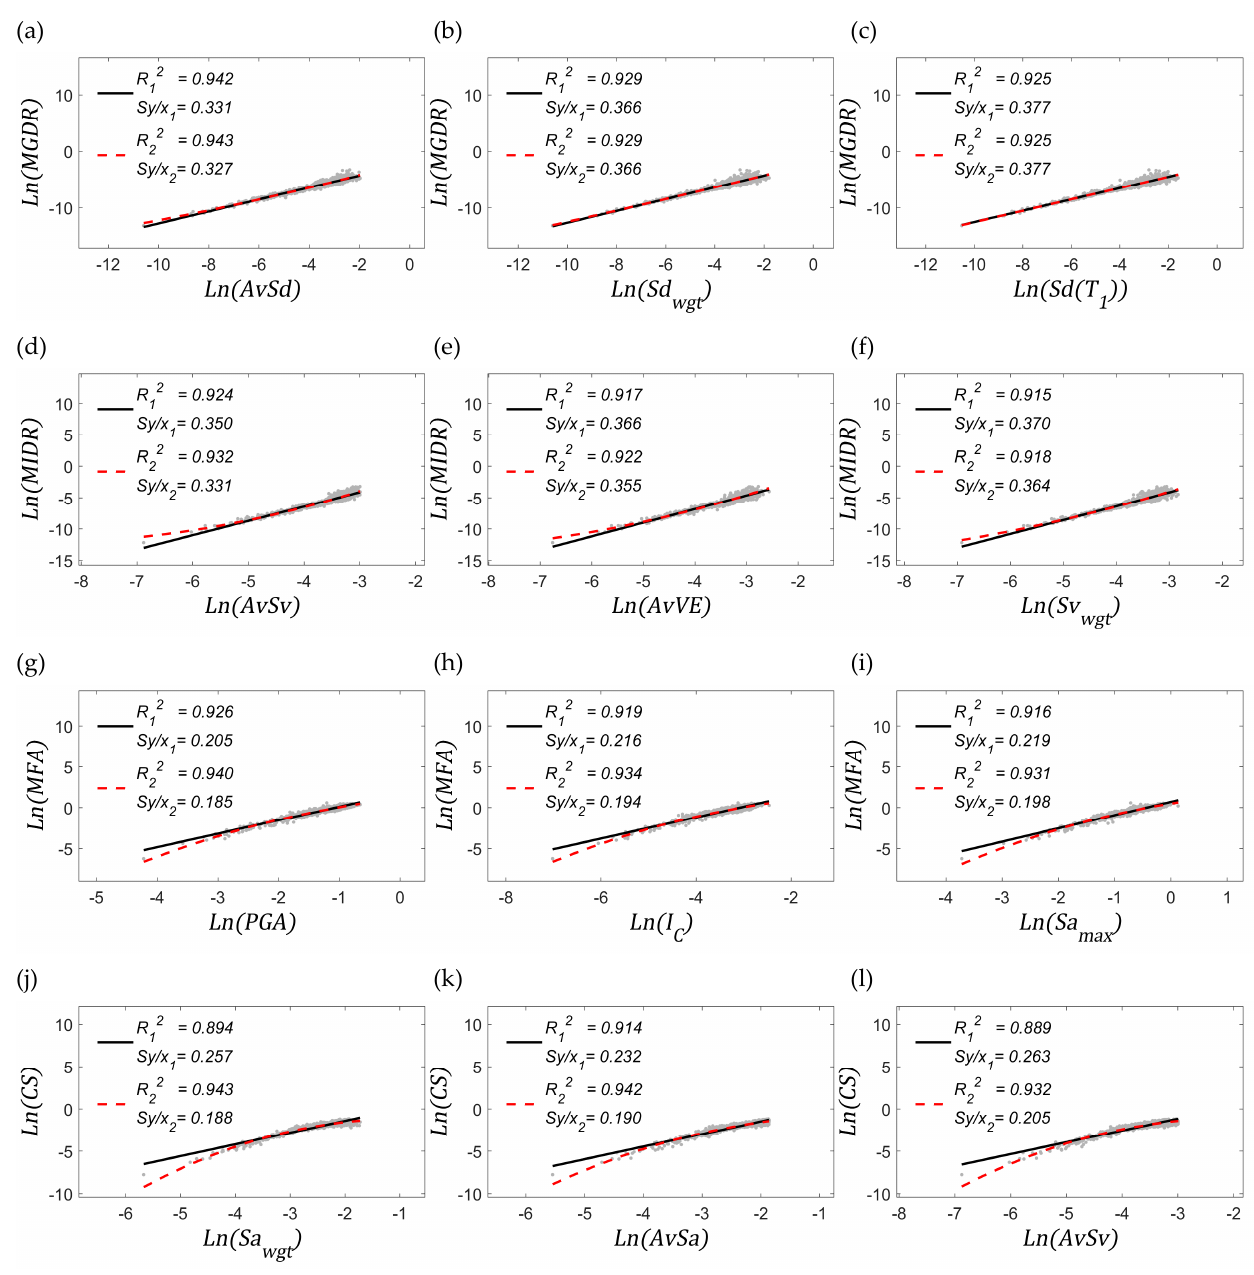
Figure 8. ( a – l ) Statistical properties with both elastic and inelastic results; in these figures 𝑁 (cid:3010)(cid:3014) is equal to